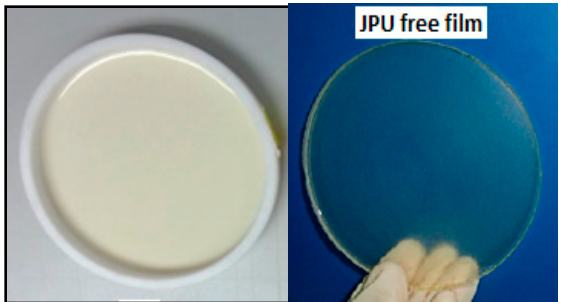
Figure 2. JPU film produced by casting the dispersion in Teflon mold.